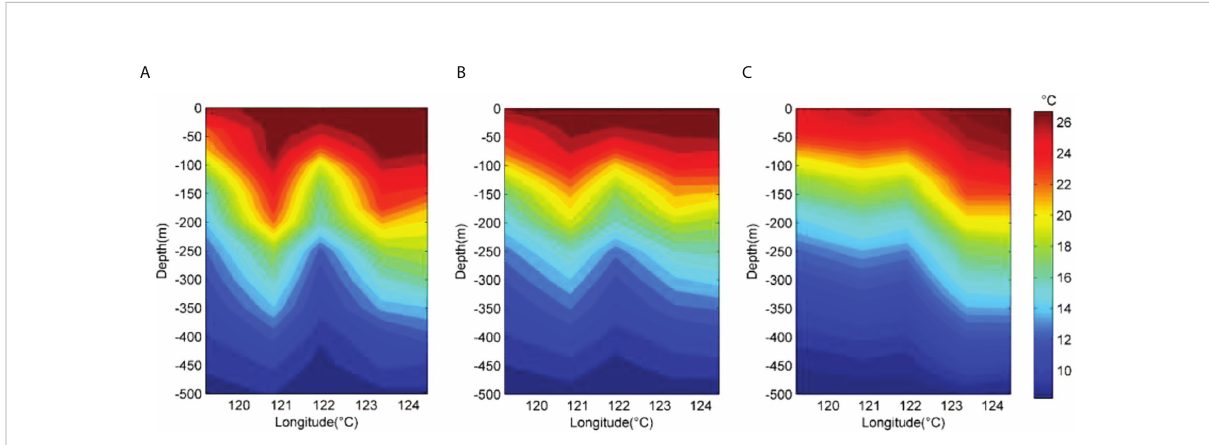
FIGURE 13 Temperature pro fi les of the cross-section (Figure 8) based on the observations (A) , expanded temperature fi eld (B) and WOA18 (C) ,